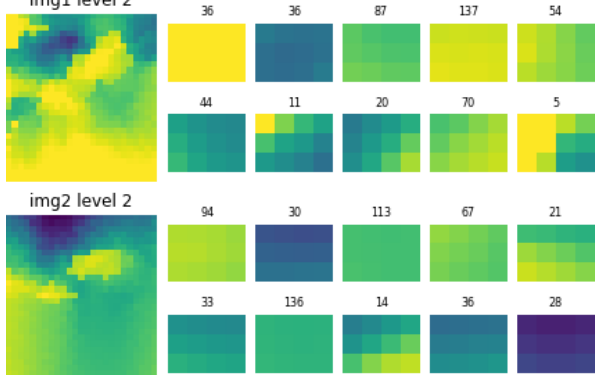
Figure 11. Illustration of multiple-point histogram cluster represen- tatives and sizes for two scalar field horizontal sections, at the 3rd upscaling level; the left column shows the two 2D voxets; for the other columns the first and second rows, and the third and fourth rows, display the 10 cluster representatives and their size (number of counted patterns attached to the cluster representative) for the first voxet and for the second voxet, respectively; their order reflects the best similarity between the cluster representatives for both voxets.